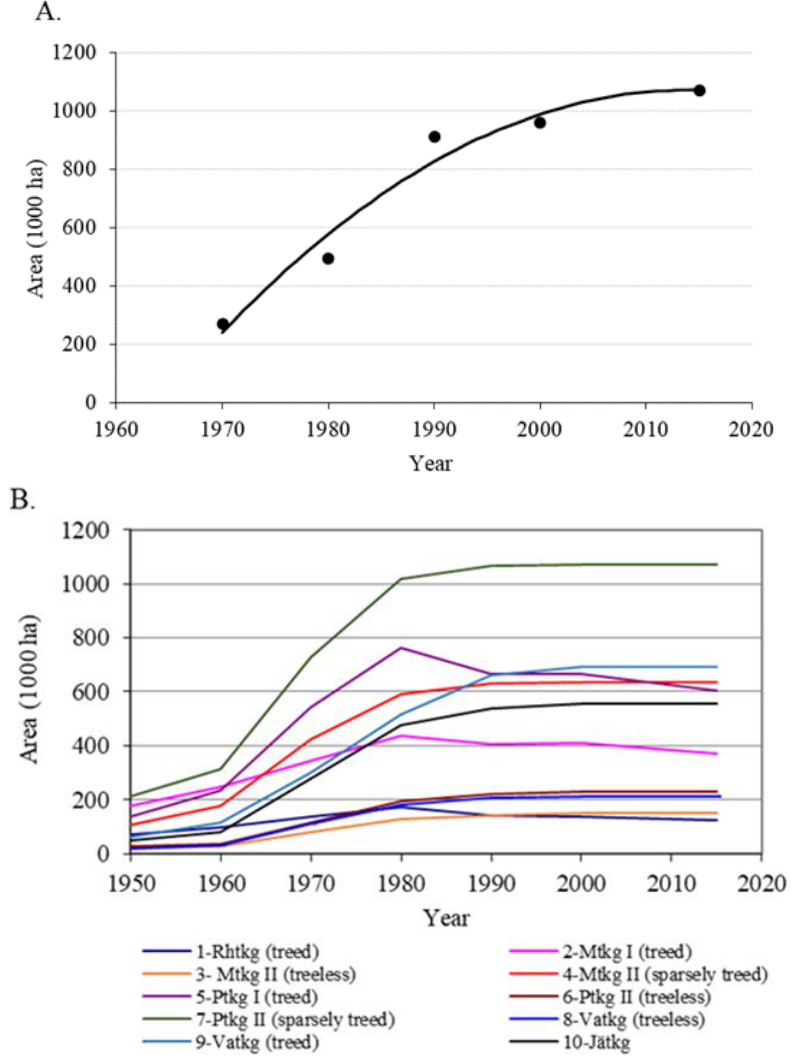
Figure 2. A) The peatland area difference (black dots) between the annual statistics of forestry-drained areas (Keltikangas et al. 1986, Finnish Statistical Yearbooks of Forestry 1979–2014) and the total peatland area estimates of the National Forest Inventories (Finnish Statistical Yearbook of Forestry 2014). The curve is